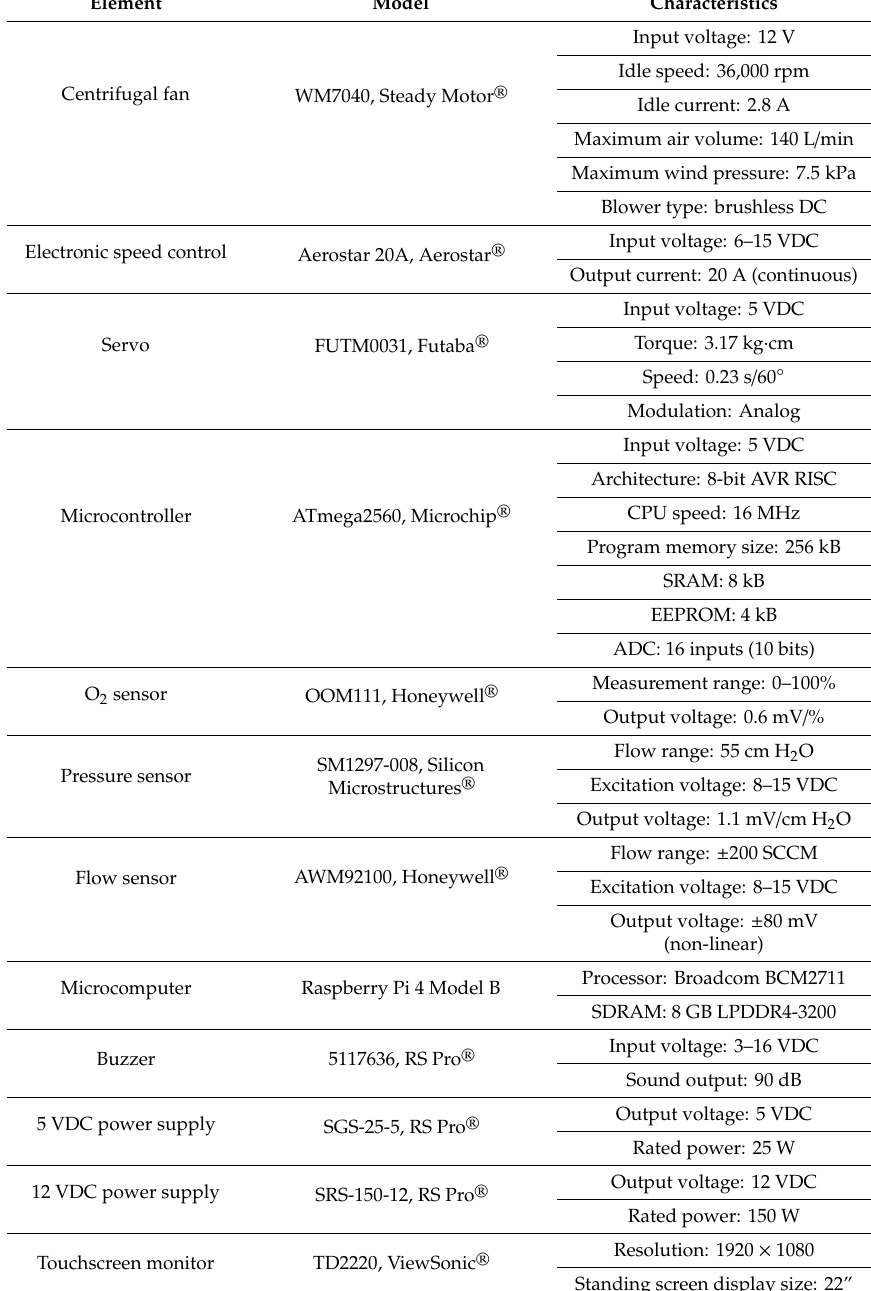
Table 1. Main parameters of the ventilator